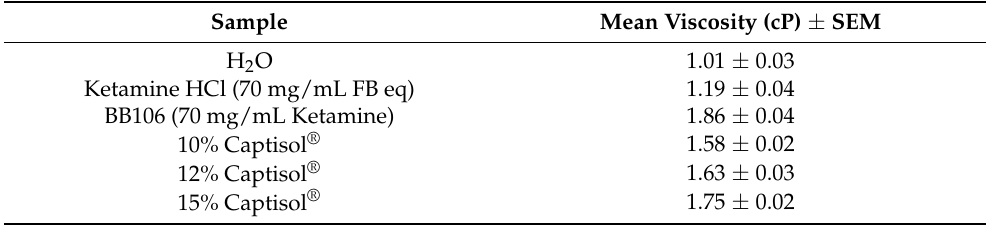
Table 4. Measured viscosities of Captisol ® , Ketamine HCl, and KetCap Solutions. Samples